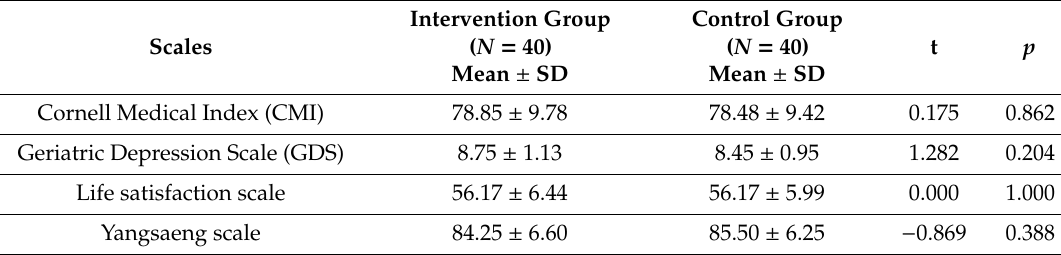
Table 3. Homogeneity of study variables at the pre-intervention.